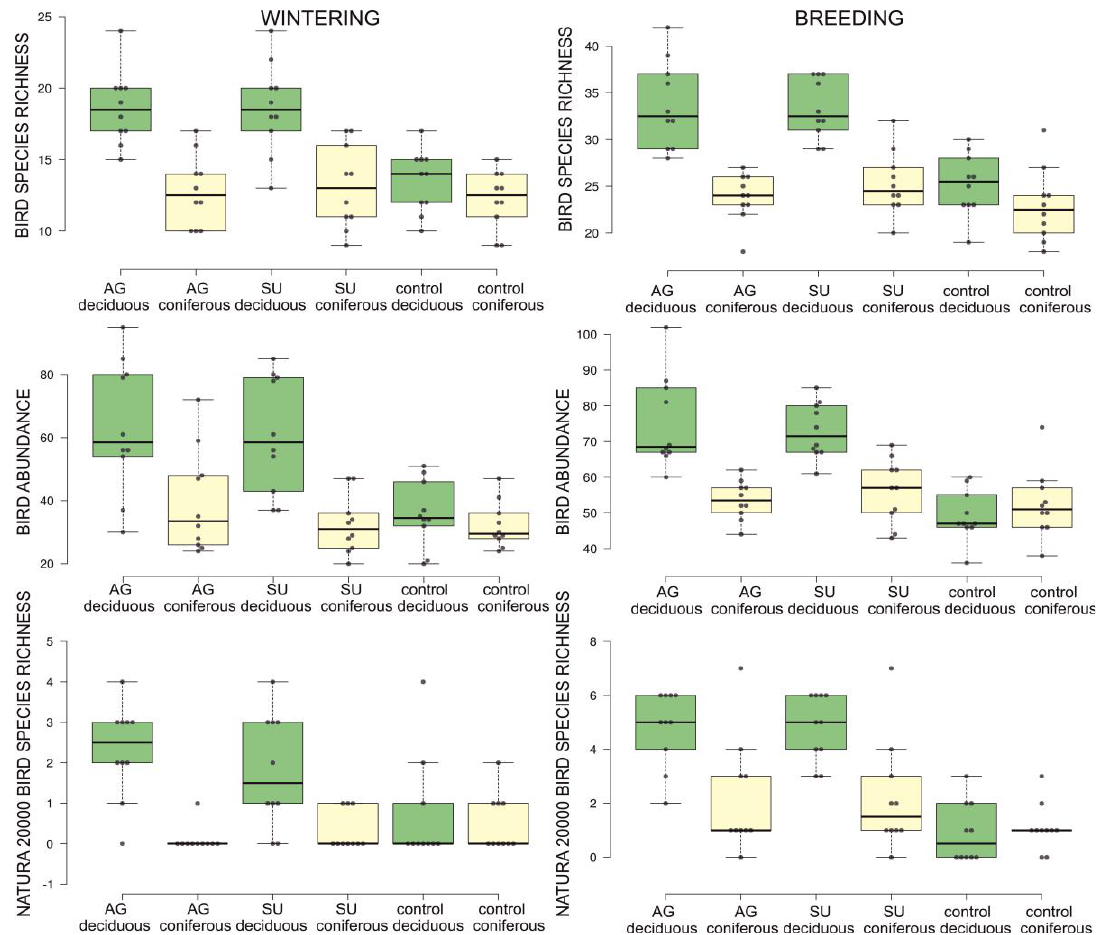
Figure 1. Box − plots showing differences in bird diversity metrics (RICHNESS—total species richness, ABUNDANCE—number of wintering individuals or breeding pairs, NATURA—species richness of birds annexed in Bird Directive of UE) in plots localized in long − lasting territories of goshawks (AG), Ural owls (SU) and control random sites. Medians, 95% confidence intervals, and minimum with maximum values are presented. Dots represent samples – their number is equal to number of samples with particular values for selected bird